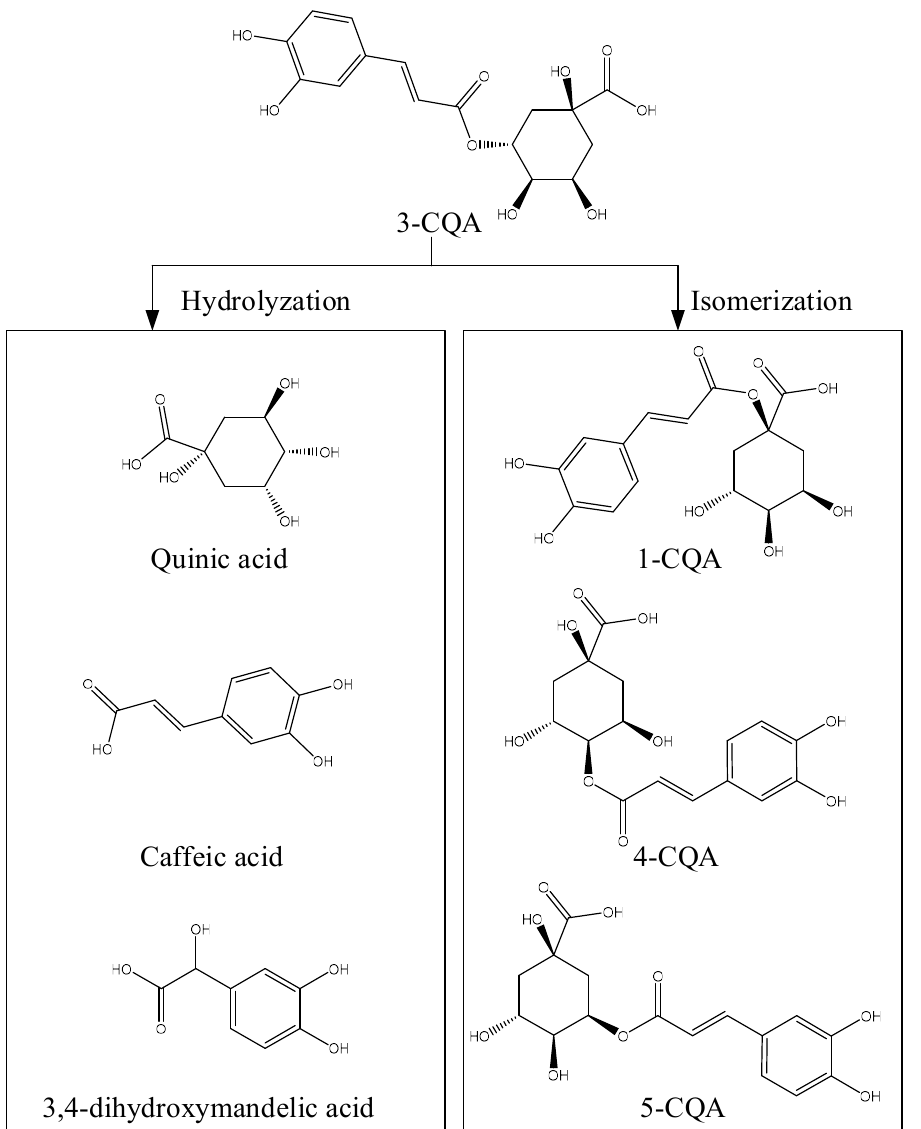
Figure 5. The proposed hydrolysation and isomerisation of 3-CQA in weakly basic conditions. 1-CQA represents 1-ca ff eoylquinic acid, 3-CQA represents chlorogenic acid, 4-CQA represents 4-ca ff eoylquinic acid, and 5-CQA represents 5-ca ff eoylquinic